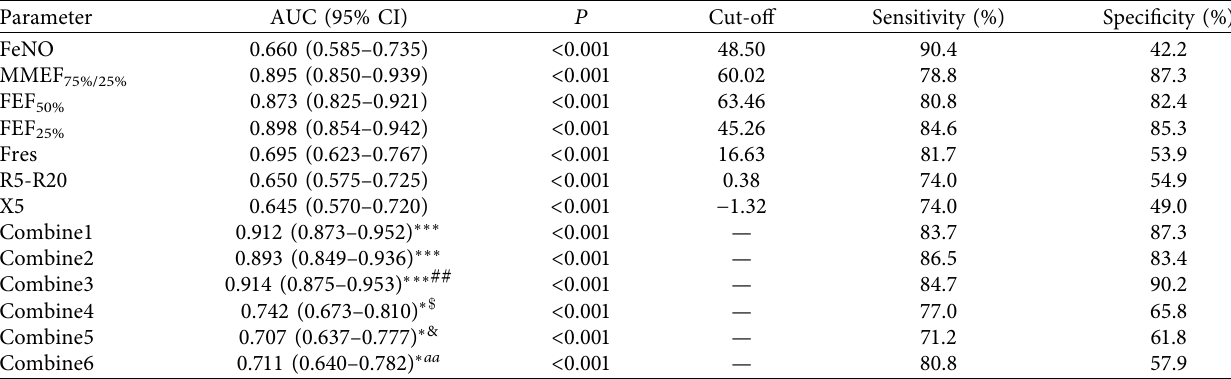
Table 4: Optimal cut-off values for the prediction of CVA.